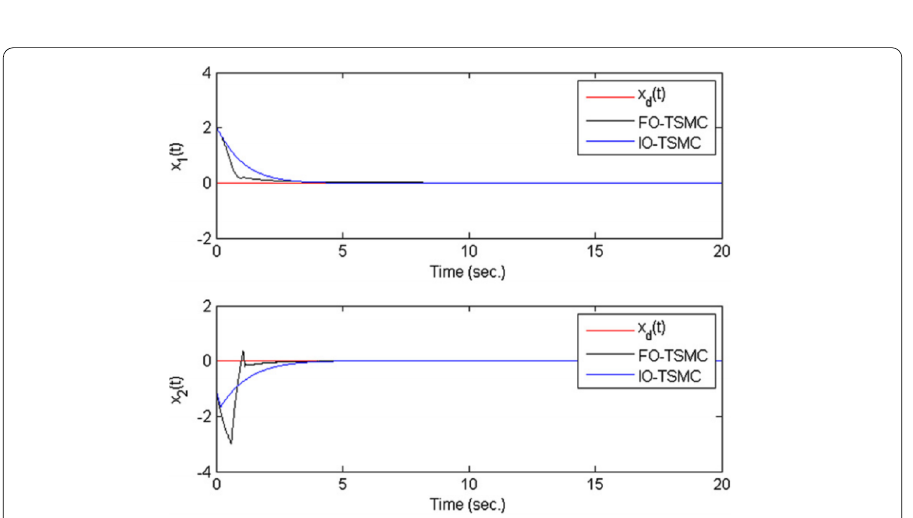
Figure 4 State evolutions of the magnetic bearing system obtained in [25]